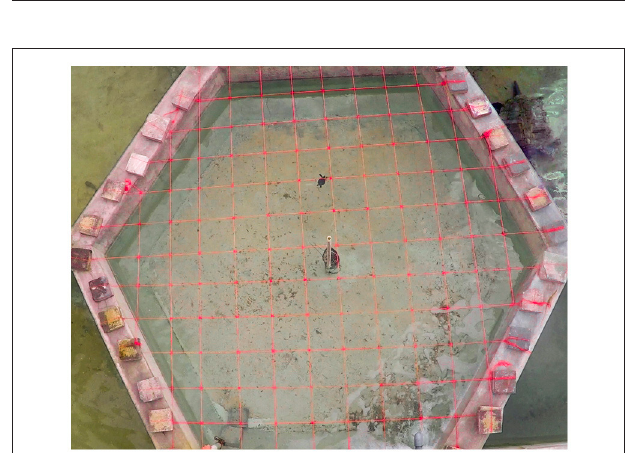
FIGURE 3 | Scale of the tank experiment at the Cayman Turtle Farm. The GoPro camera hoisted 5.1m above the hexagonal tank filmed each turtle for 25min per treatment. Each square is 25cm by 25cm to serve as a distance